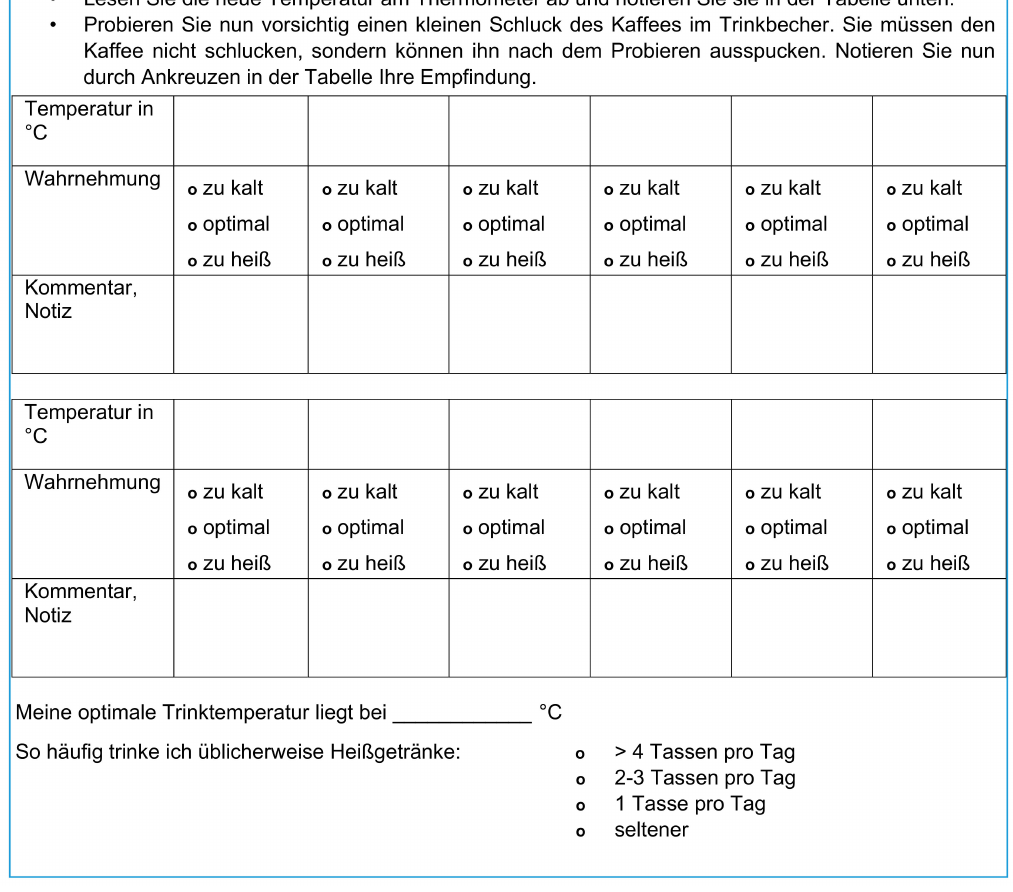
Figure A1. Experimental sheet for each participant of the trial (original in